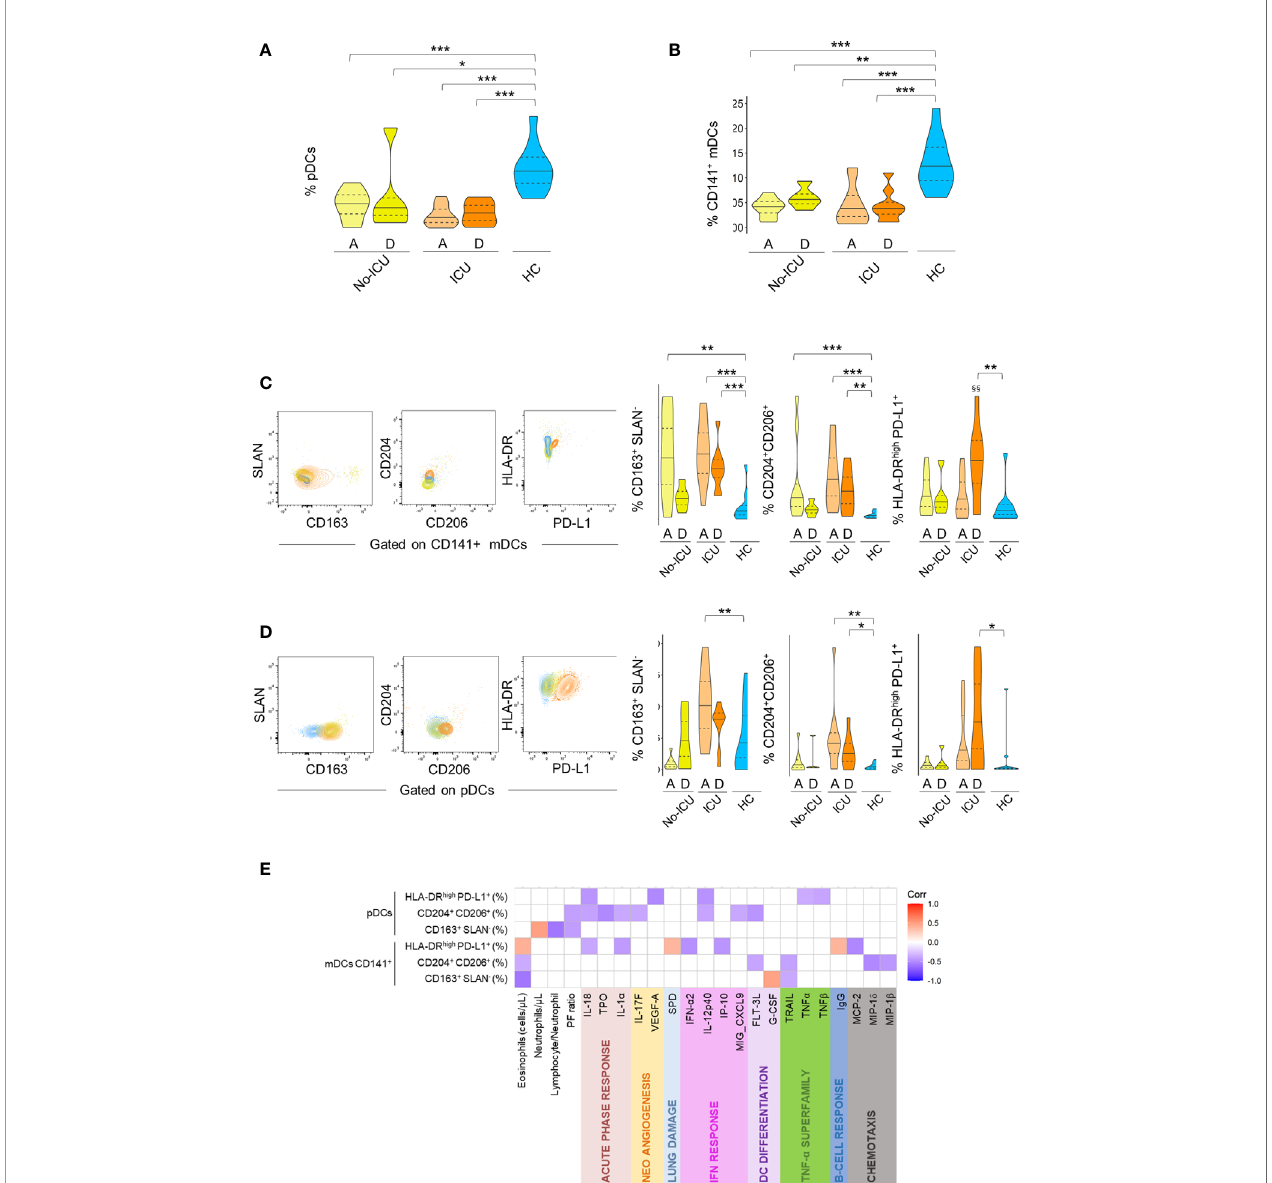
FIGURE 5 | Immune regulatory phenotype of dendritic cells in severe COVID-19. Frequency of pDC cluster (A) and CD141+mDC cluster (B) identi fi ed by X-Shift within total CD45+Lin − cells in the different groups. ( C – D) Illustrative dot-plots (left) of bi-dimensional hierarchical gating strategy were used to further analyze the phenotype of CD141+mDCs (C) and pDCs (D) from No-ICU (yellow) and ICU (orange) patients at discharge and healthy control (blue) and the respective graphs (right). Wilcoxon matched-pairs signed rank test to the paired analysis of the two-time points and signi fi cant P values are shown: §§ p < 0,01. Mann – Whitney U-test were used for comparison with healthy controls: ***p < 0,001; **p < 0,01; *p < 0,05. (E) Correlation matrix identifying relations between frequency of the identi fi ed populations within pDCs and CD141+mDCs and serum markers from both time-points and from patient and control groups; Spearman Rank correlation coef fi cient was used and p < 0.05 are